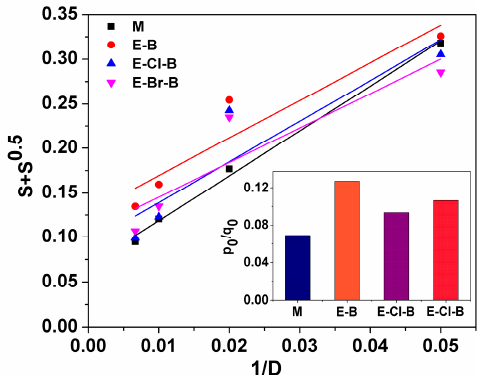
Figure 10. Charlesby–Pinner plots for EPDM/butyl rubber composites at various irradiation doses.